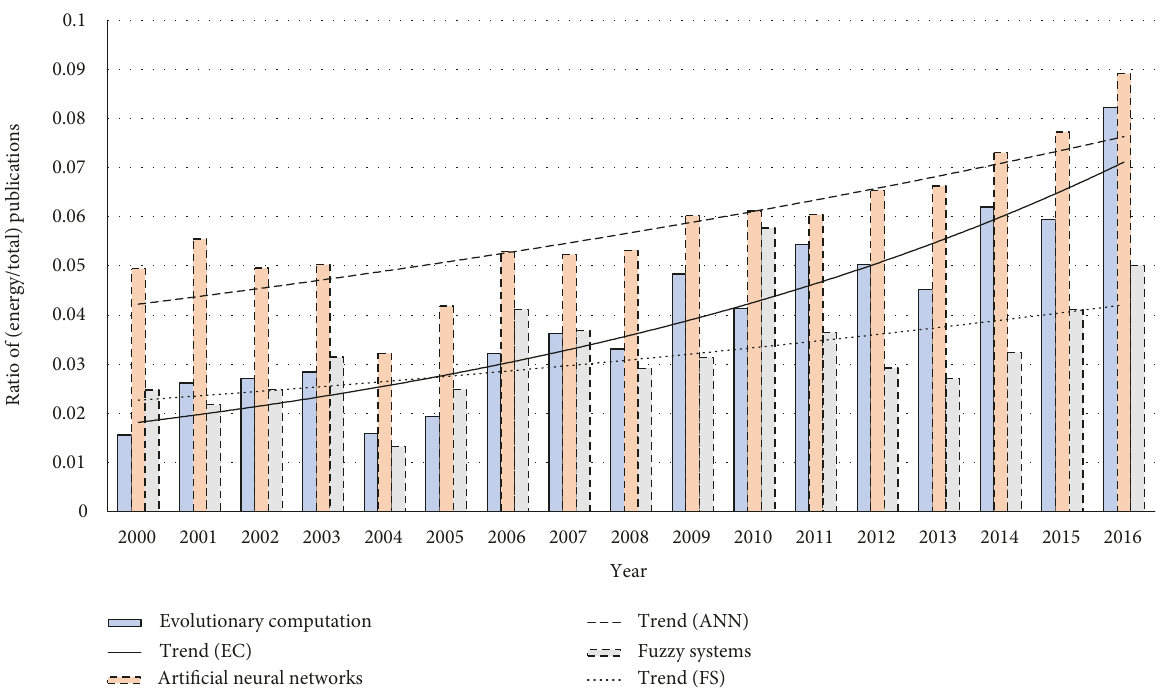
Figure 6: Ratio between energy domain and total of publications by main fi elds of computational intelligence. The trends suggest an increase in the applications of EC in the energy